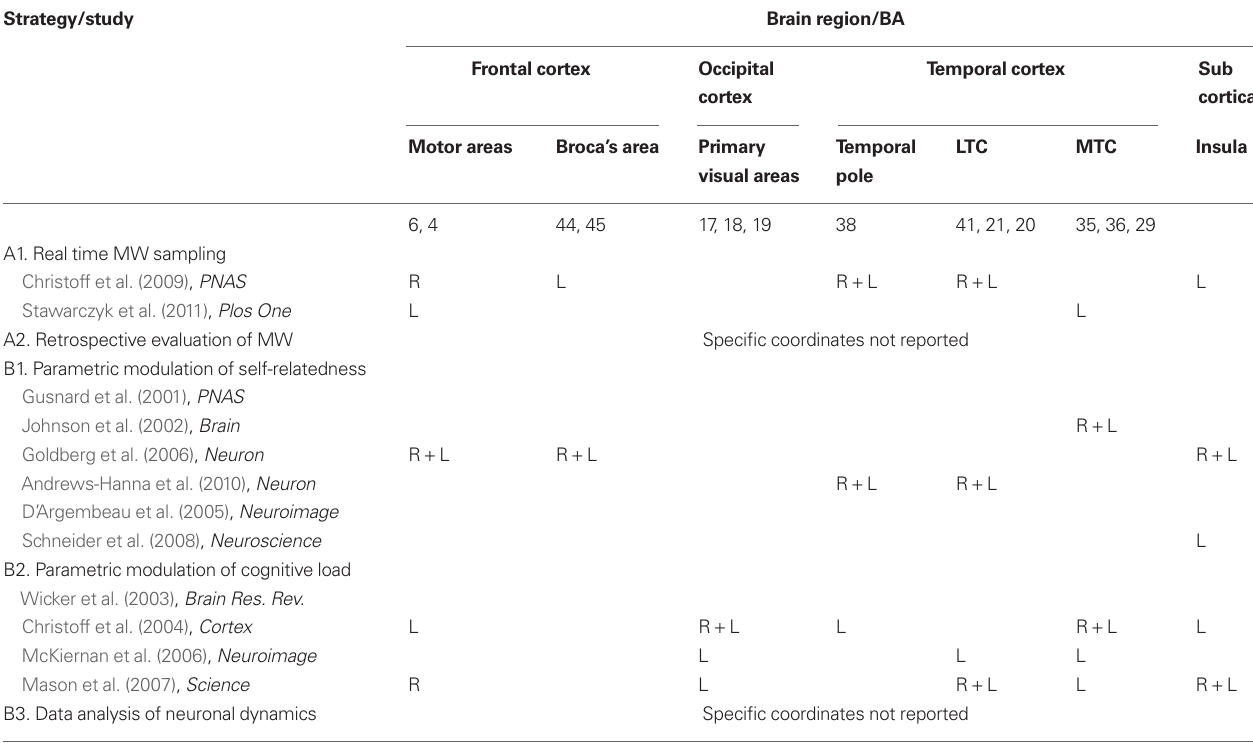
Table A1 | A summary of overviewed studies and their non-DMN-related